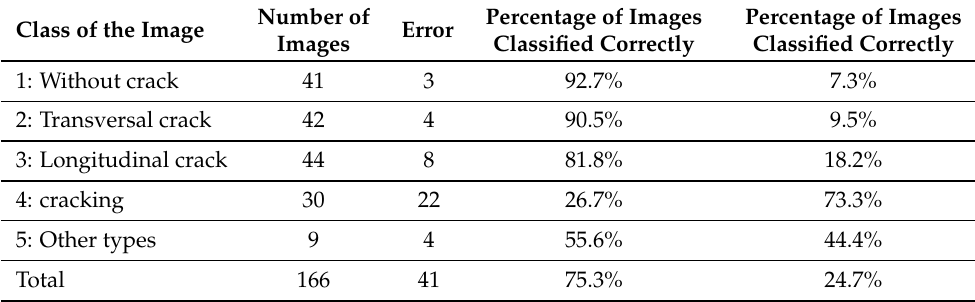
Table 5. Results obtained for different classes of the images.